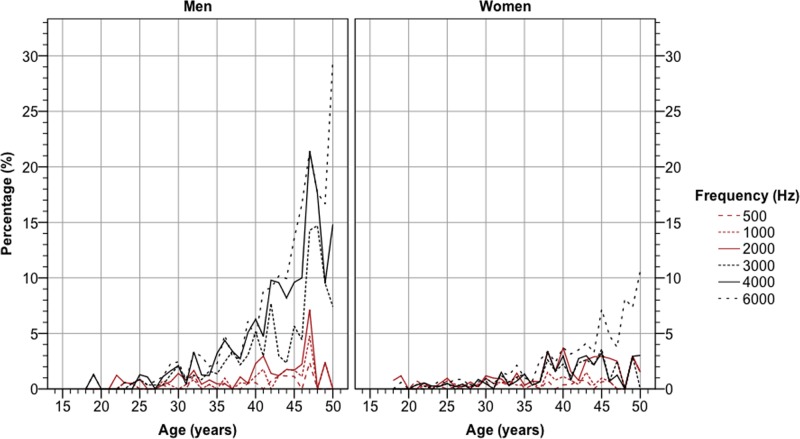
Prevalence of a pure tone hearing threshold above 20 dB in both ears versus age, stratified by frequency and sex.